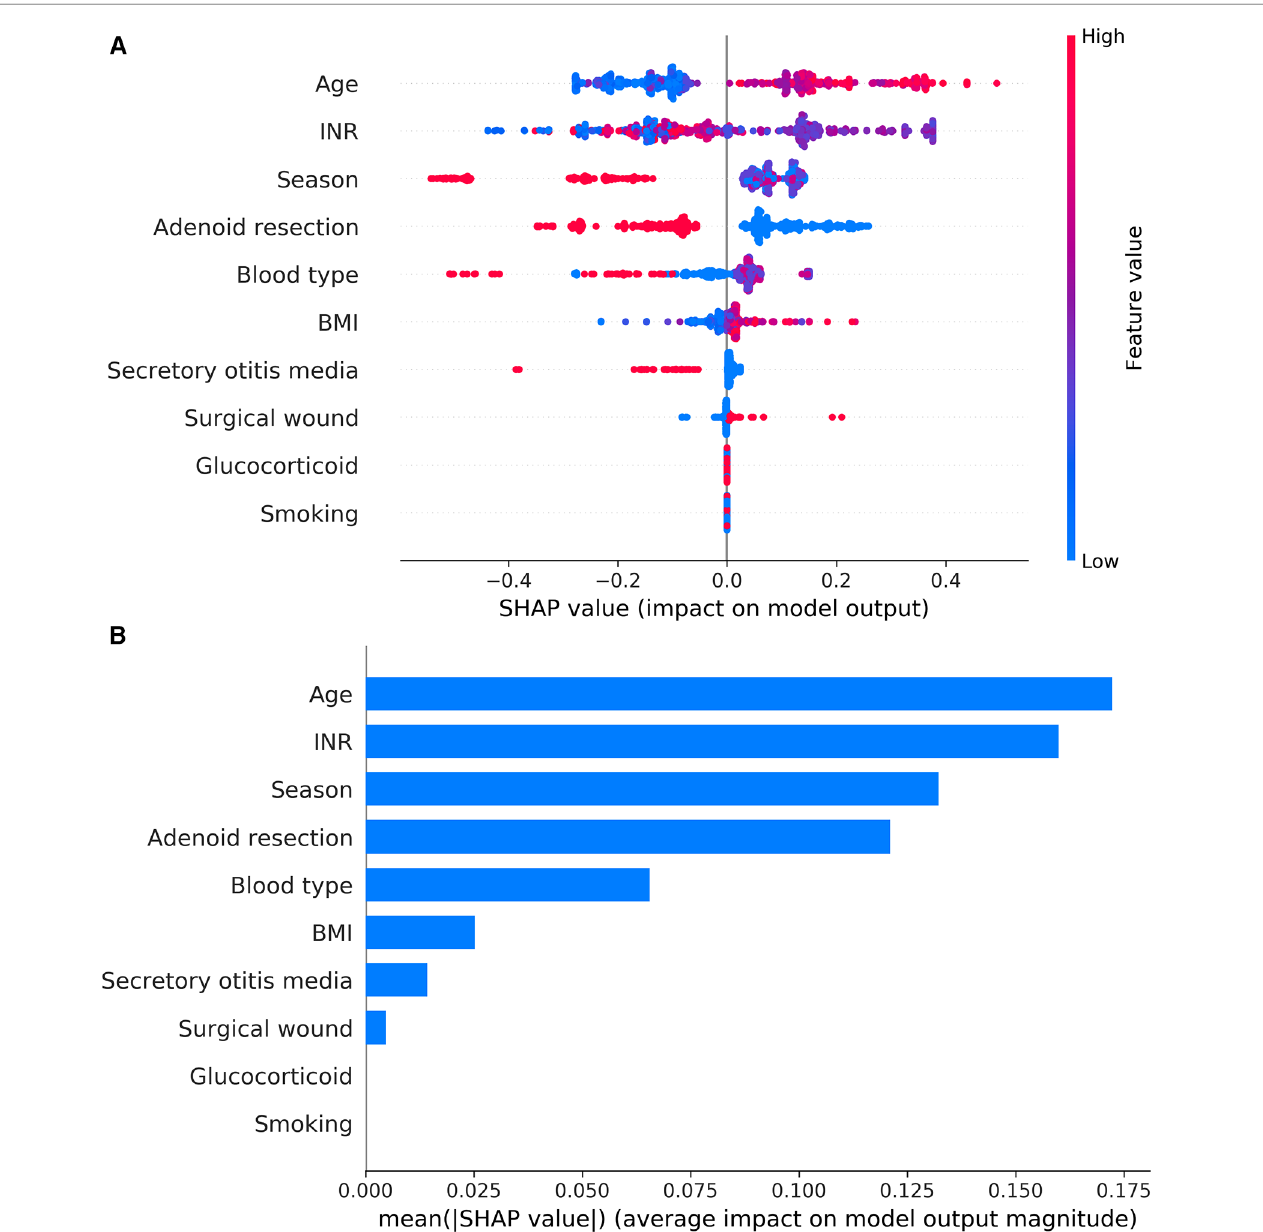
FIGURE 5 ( A ) SHAP summary plot of clinical features. Each feature of each patient was colored by a point according to an attribute value. Red represents a higher value, and blue represents a lower value. ( B ) shows the importance matrix plot of the XGBoost model, describing the importance of each variable in predicting PTH. Adenoid resection: